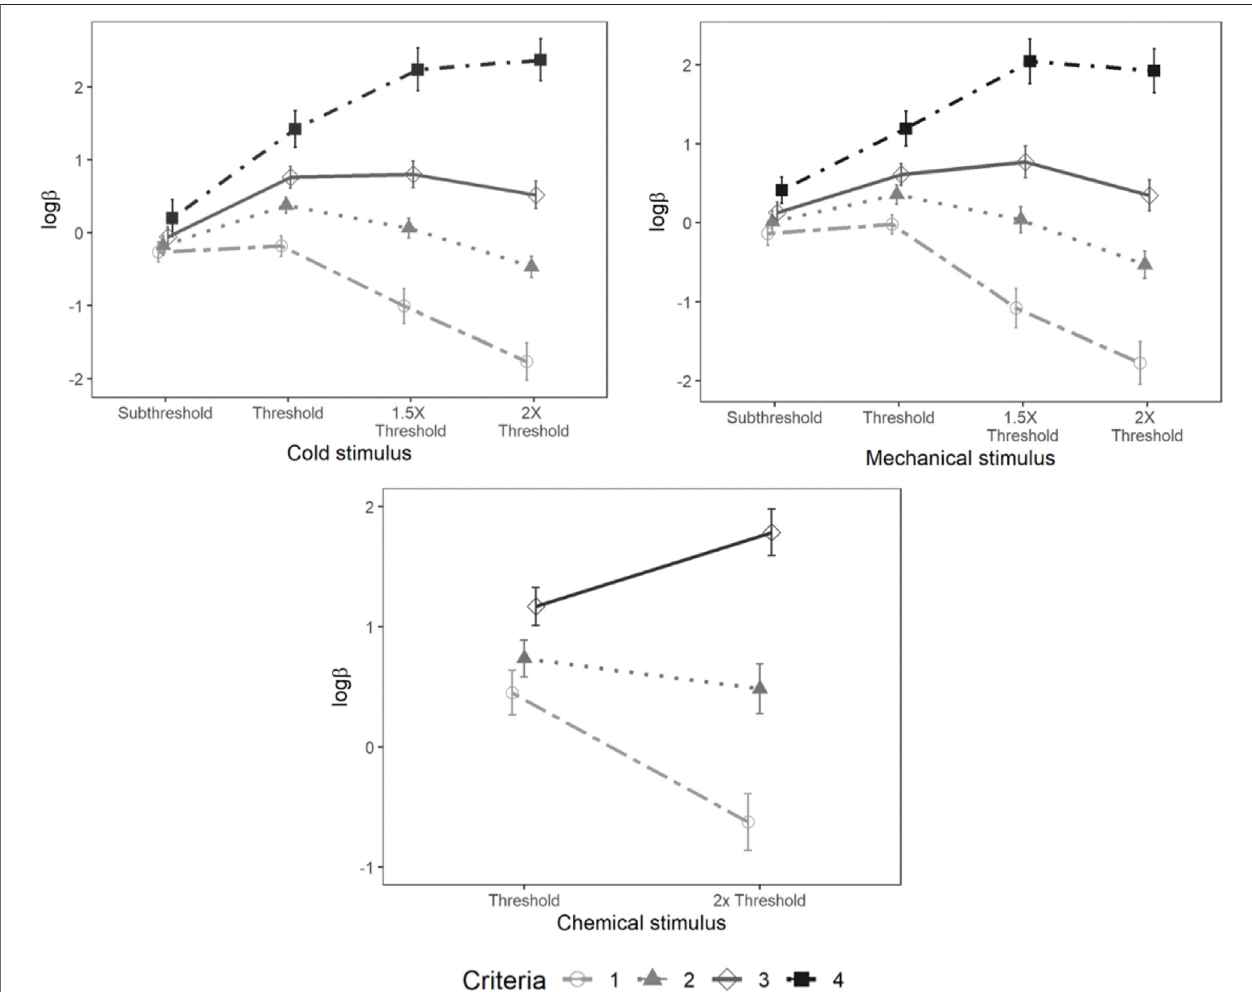
FIGURE 10 | Loglikelihood ratio for cold, mechanical, and chemical stimulus. Each horizontal axis is stimulus intensity and vertical axis is ln β . The points are the means and error bars are the SE of the estimates. The lines indicate different criteria.